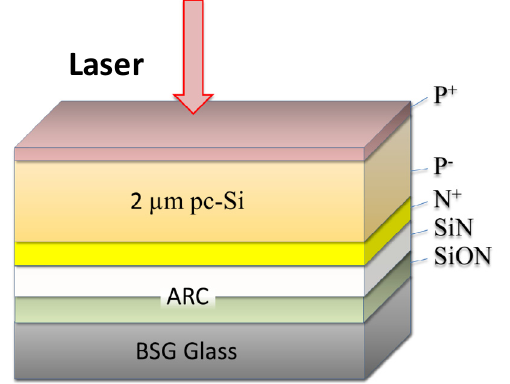
Fig. 1. Schematic diagram of the sample.